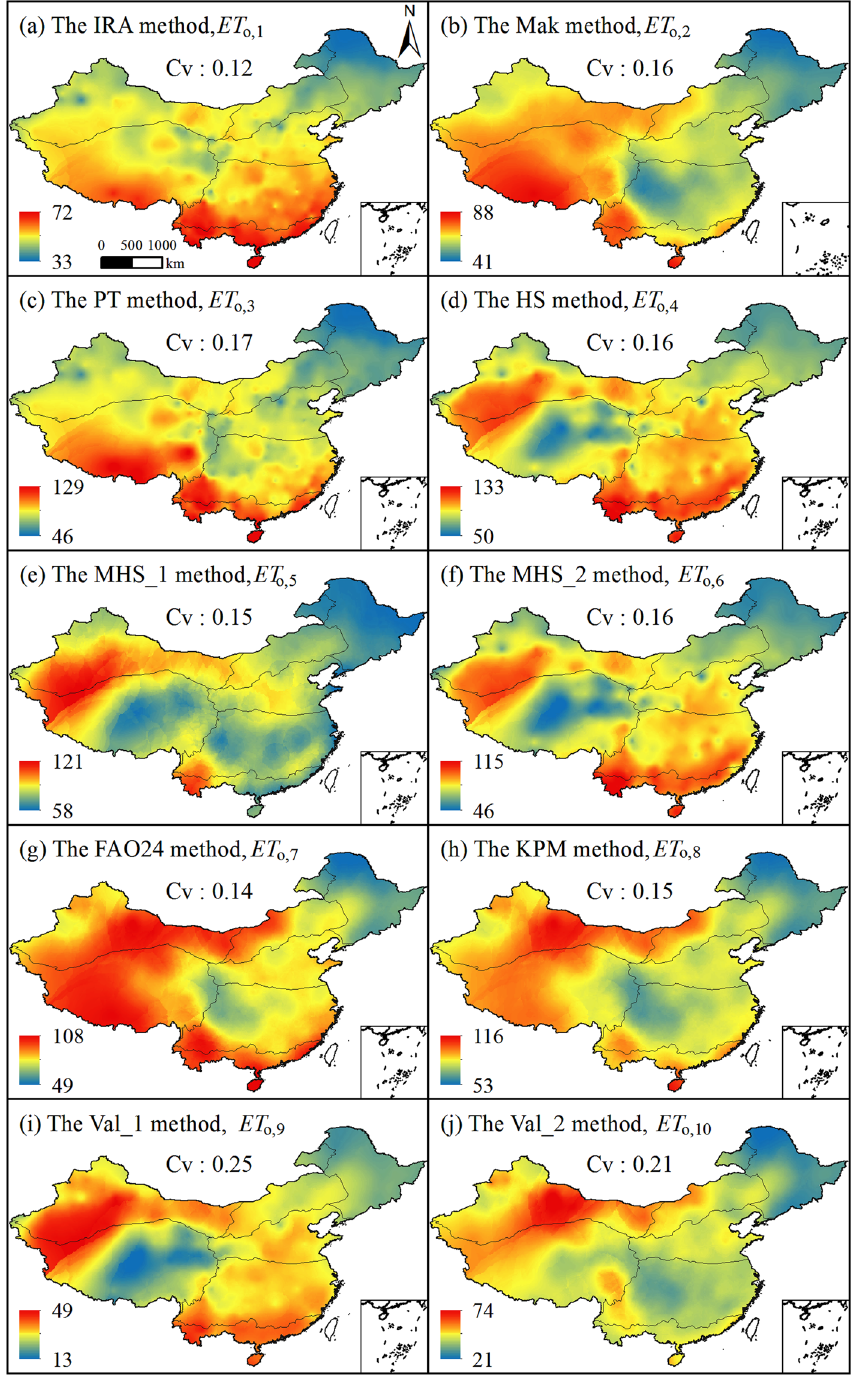
Figure 4. Spatial distribution of multi-year mean monthly ET o,i in China. (ArcGIS 10.2, http://map.baidu.com, Lingling